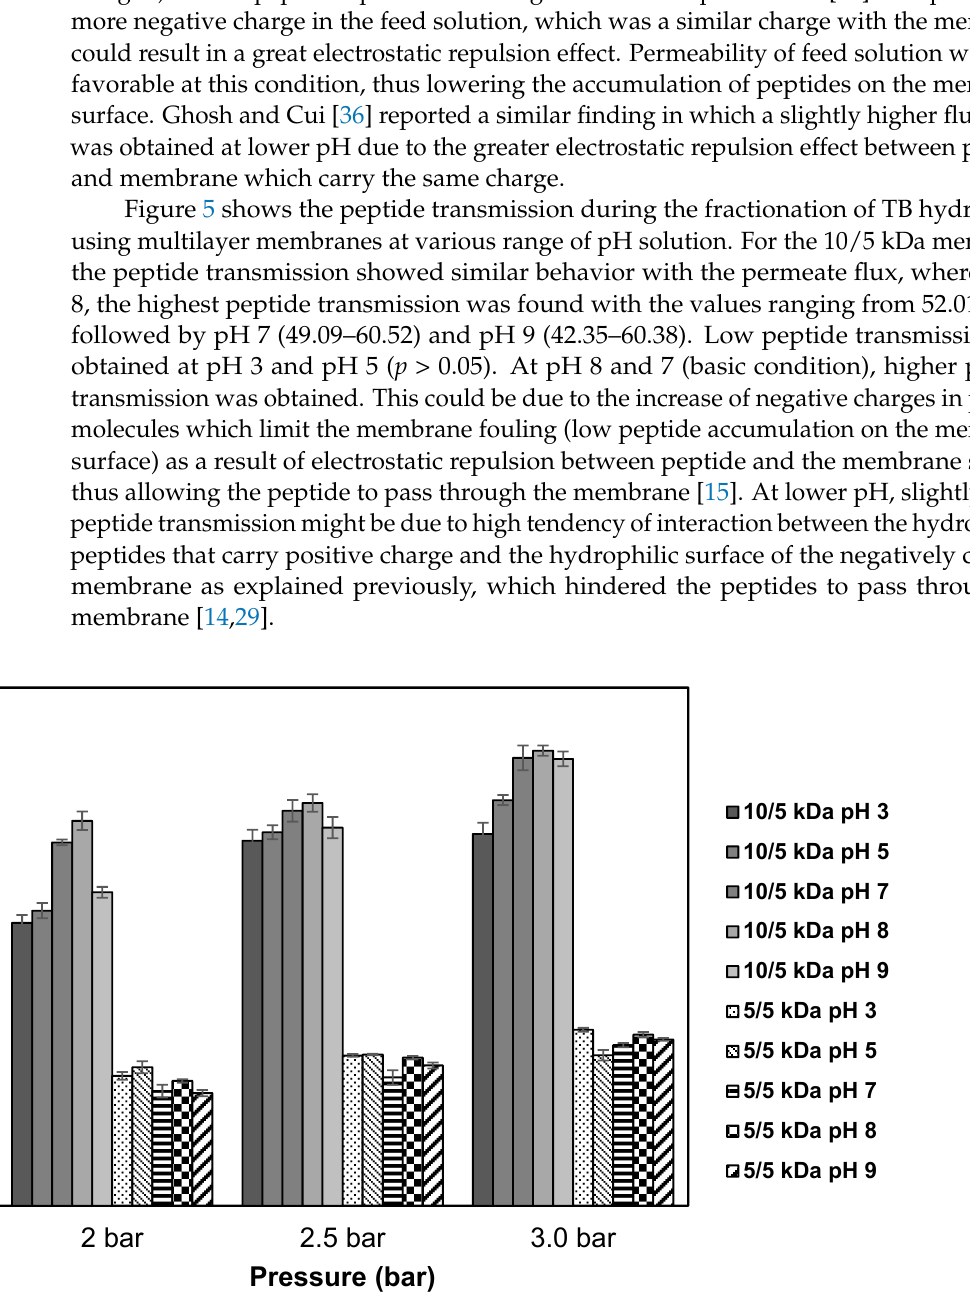
Figure 5. Peptide transmission of TB protein hydrolysate through multilayer UF membranes at different pH of feed solution.